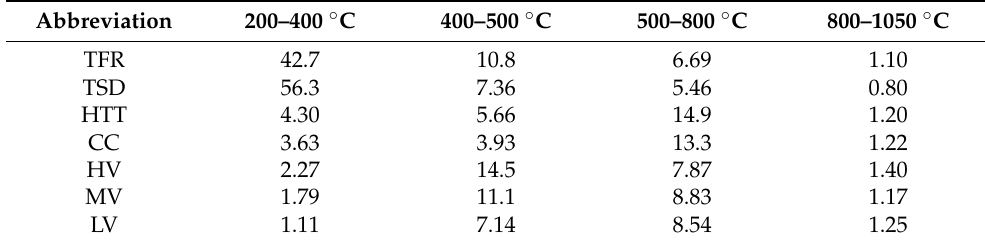
Table 6. Mass loss (wt%) for coals and bio-coals during carbonization.